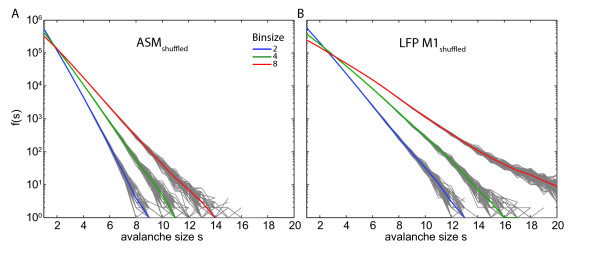
Avalanche size distributions f(s) for shuffled data. Avalanche size distribution f(s) obtained from trial shuffled data plotted in semi-logarithmic coordinates. Here, straight lines indicate exponential distributions and not a power law. Coloured lines are averages over 1000 different shufflings. Grey lines around the coloured lines are results obtained for single shufflings. (A) ASM; bin sizes: 2 (purple), 4 (green), 8 (red). (B) LFP data from M1; bin sizes: 2 (purple), 4 (green), 8 (red).